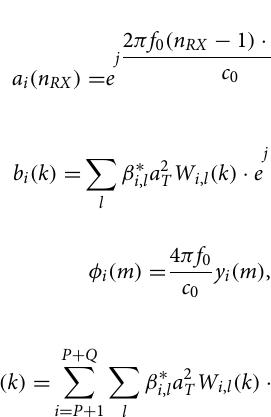
Figure 3. Block diagram of the proposed algorithm. SVD stands for singular value decomposition and ICA stands for independent component